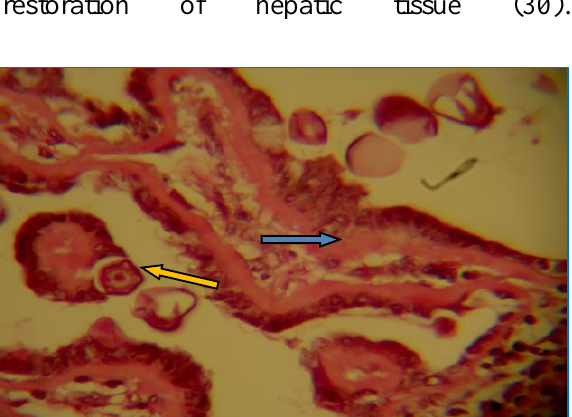
Figure, 1: G2: Liver of rabbit at 10 days post infection show hyperplasia of epithelial lining of bile duct forming